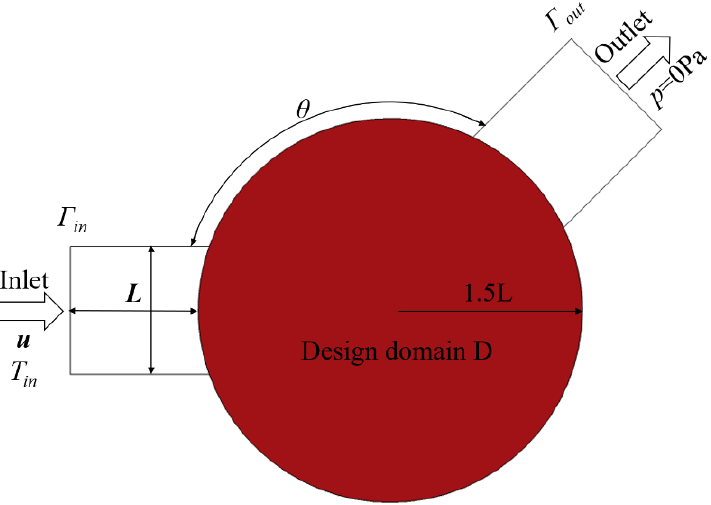
Figure 1. Design model, dimensions, and boundary conditions of the micro-channel heat sink.